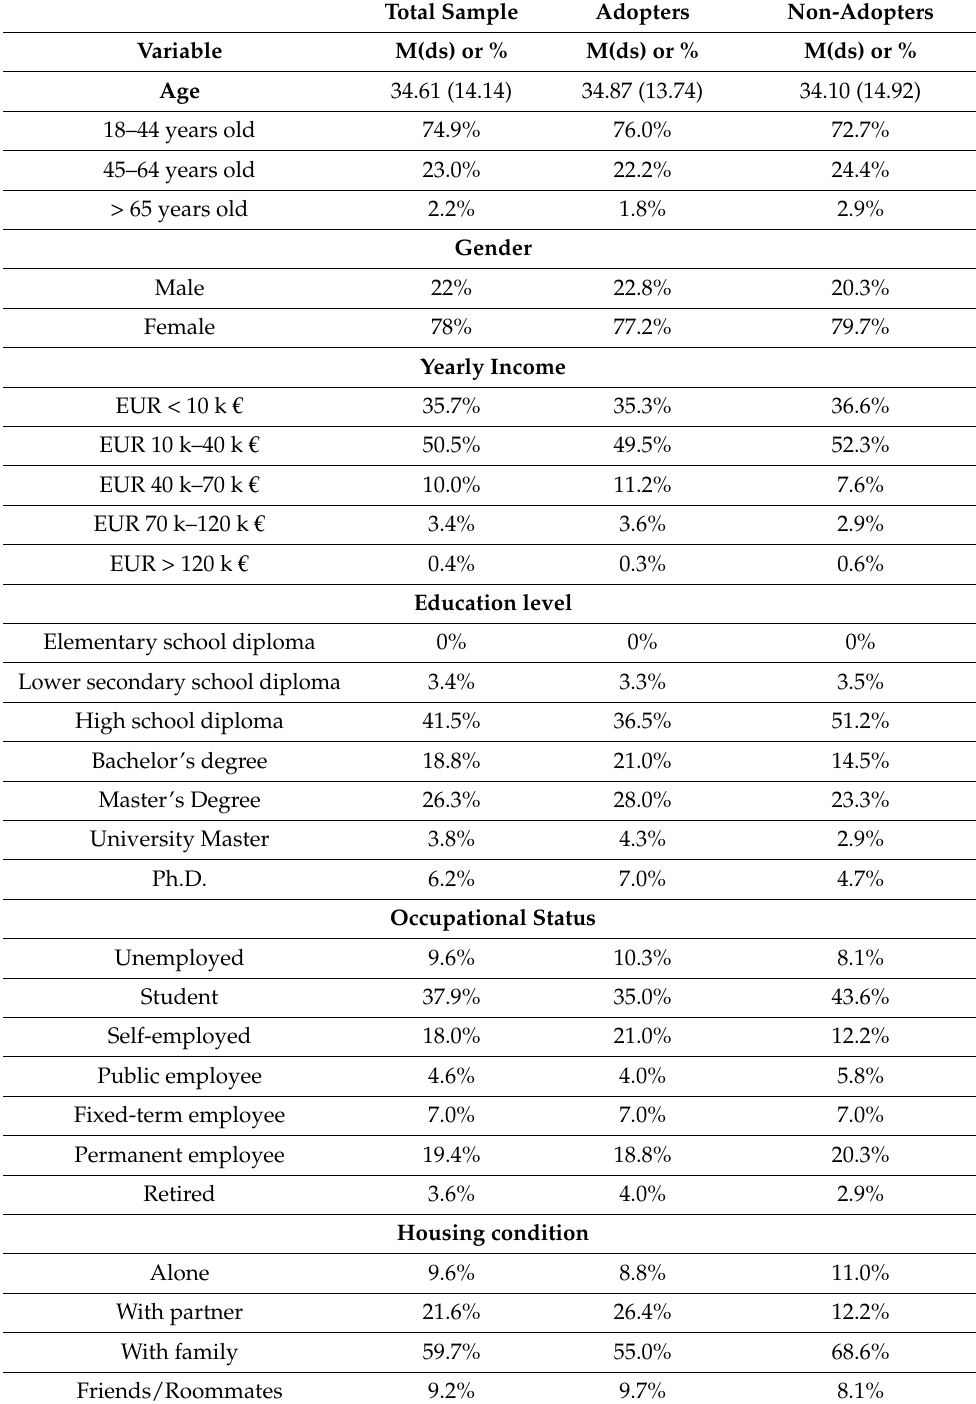
Table A2. Sociodemographic characteristics of the